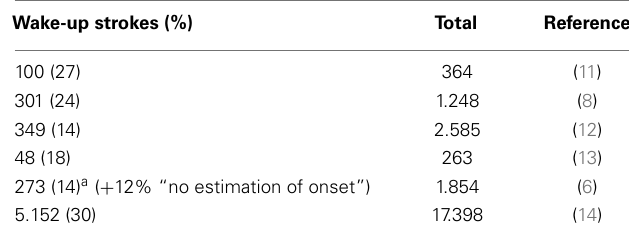
Table 1 | Incidence of wake-up stroke.